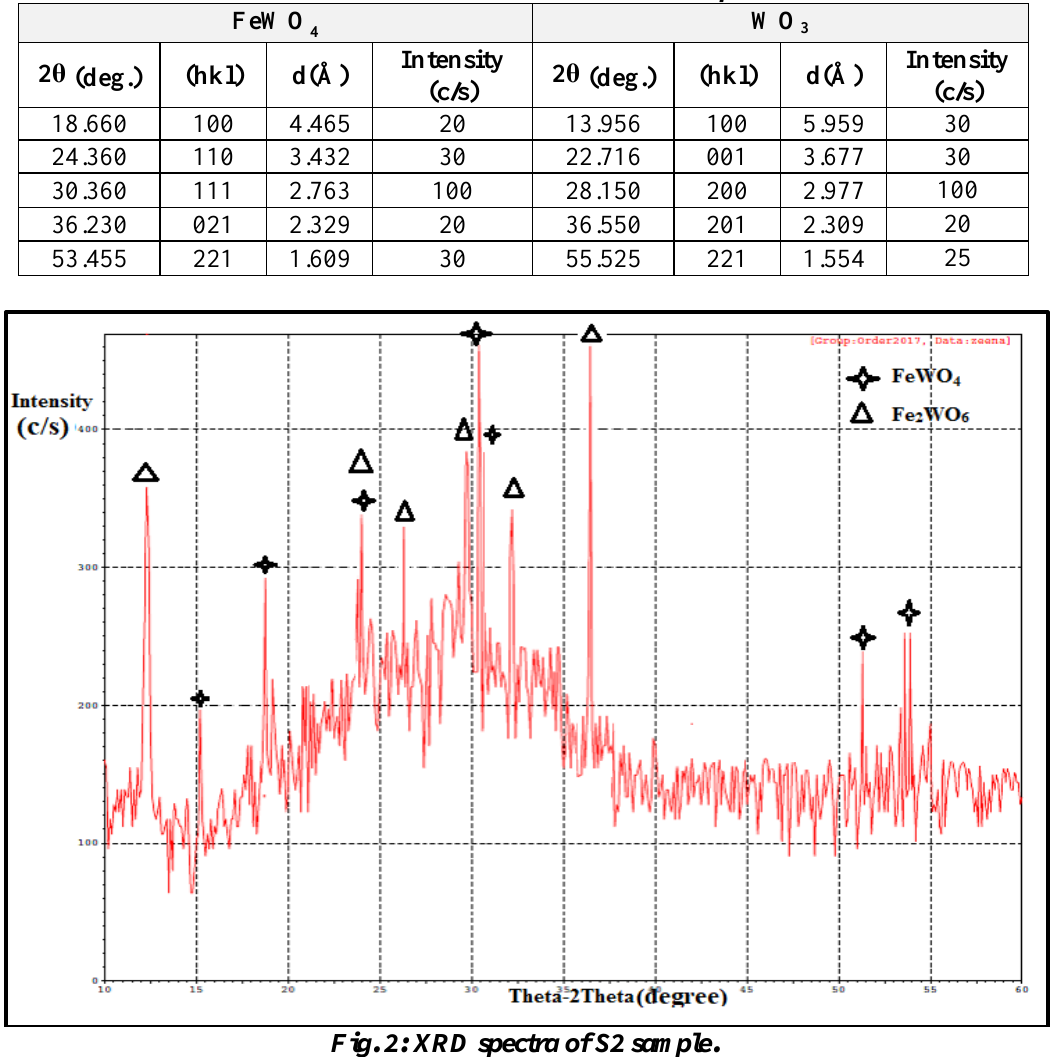
Table 3: Results data of XRD S1 sample.